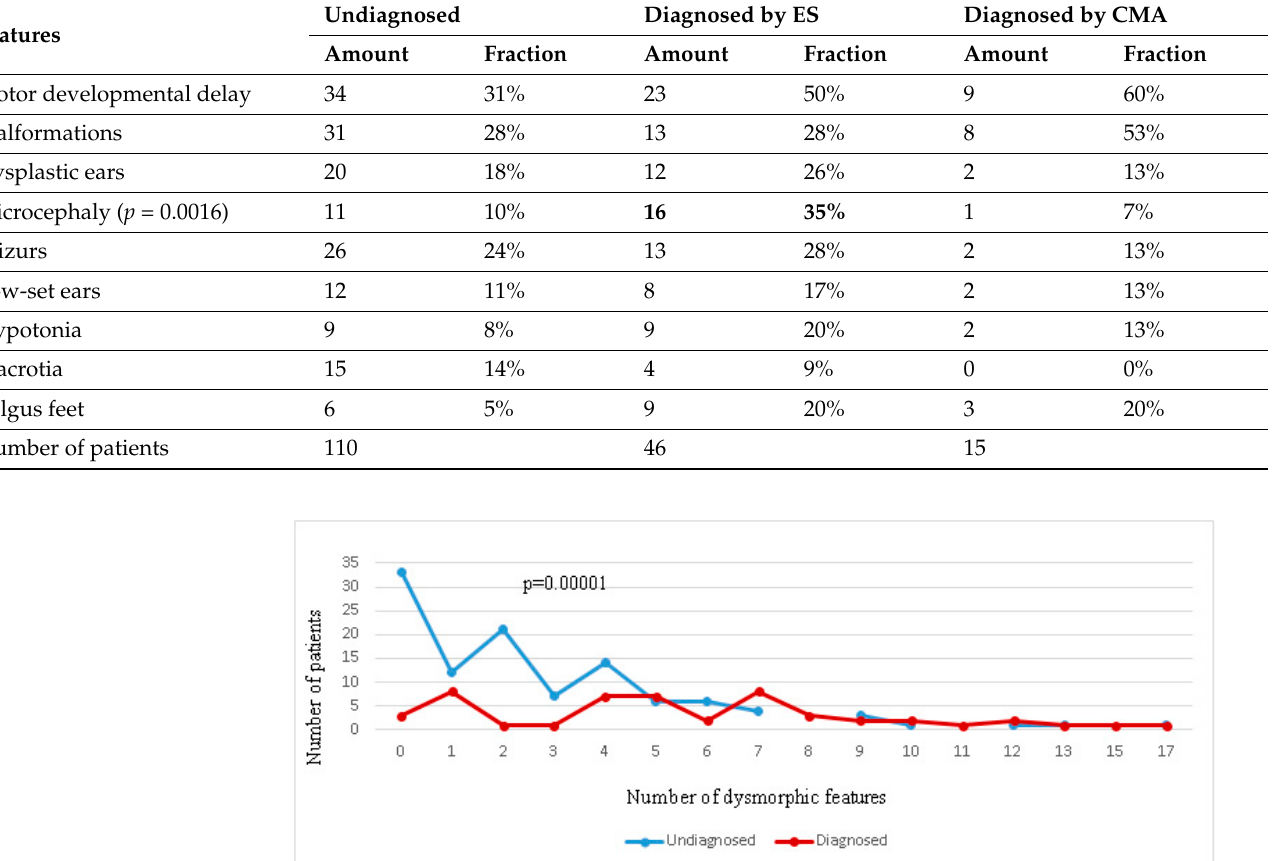
Table 5. Comparison of the most common clinical and dysmorphic features.